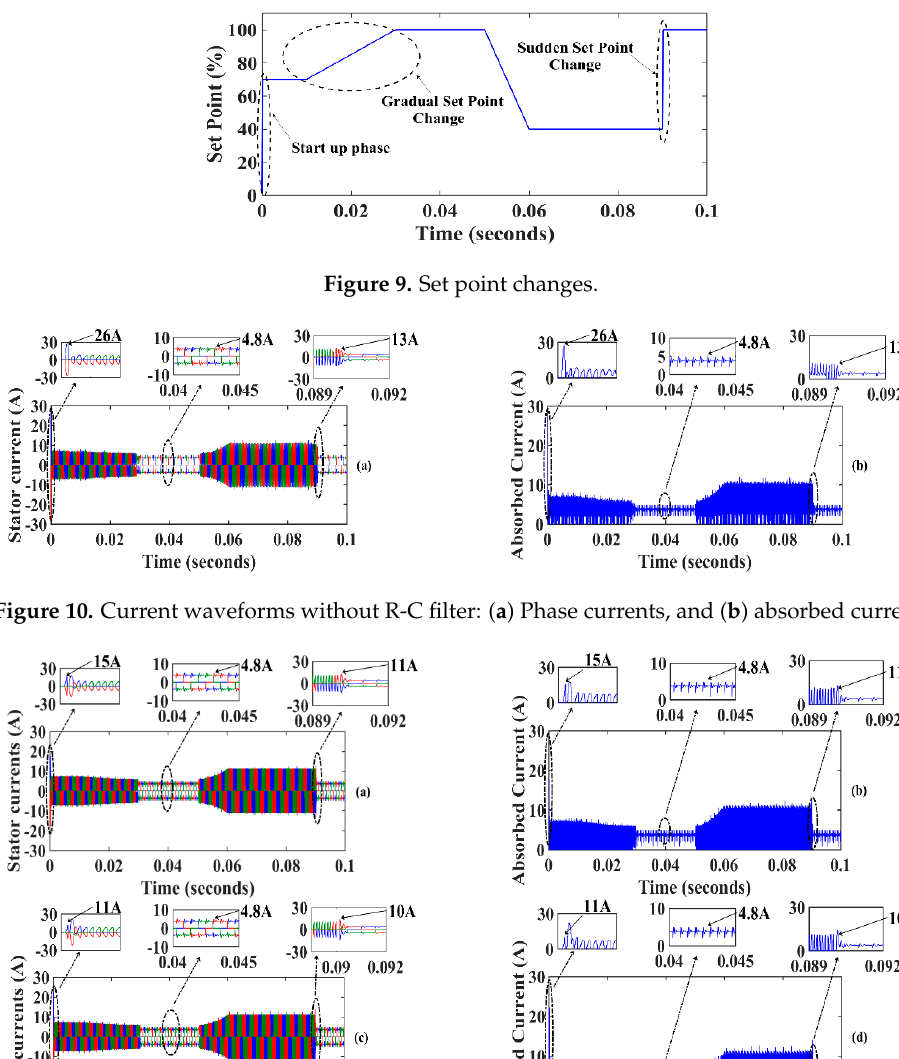
Figure 12. Gate control signal for combined “with and without an R-C filter” methods: (a) During start-up phases. (b) During set point change occurrence. Figure 13. Activated switch signal. From the reported results, without using an R-C filter control, the peak values of the phase current, and thus the input current, reached 26 A during the start-up phase and 13 A during sudden set point change, as illustrated in Figure 10a,b. However, when implementing the R-C filter with a 0.6 µF capacitor, the current values were reduced to reach 15 A and 11 A during the start-up and sudden set point change, respectively (Figure 11a,b). After changing the capacitor to 1.5 µF, the start- up and sudden set point changes currents were reduced to 11 A and 10 A, respectively (Figure 11c,d). During gradual set point change, the current waveform did not show any spike, which did not necessitate R-C filter effect activation. From these results, using relays on the six MOSFETs of the inverter seemed to be a satisfactory way to eliminate current ripples in the permanent regimes. The previous calculations, which